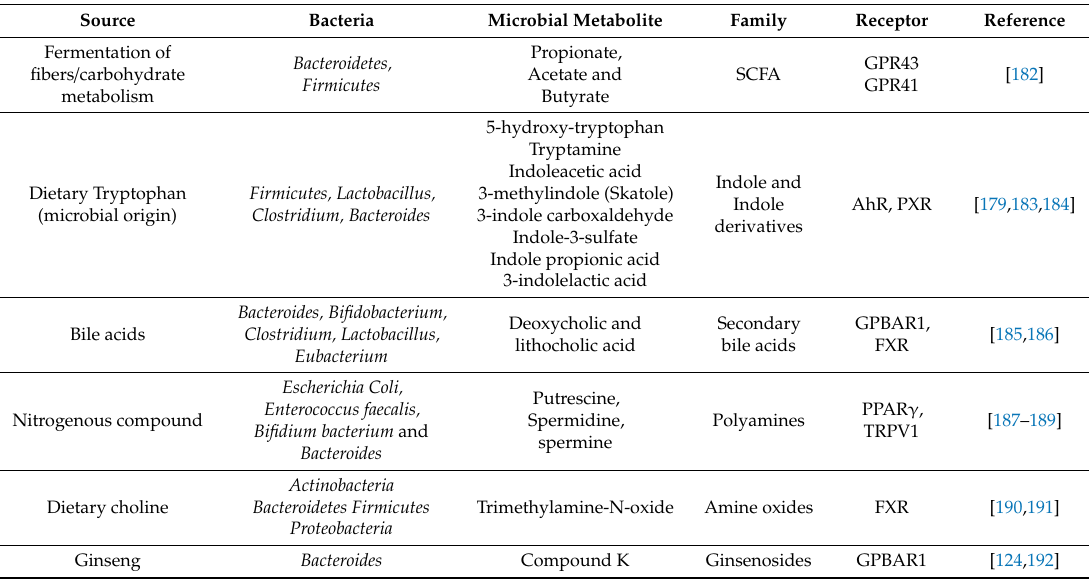
Table 4. Microbial derived metabolites and their biological